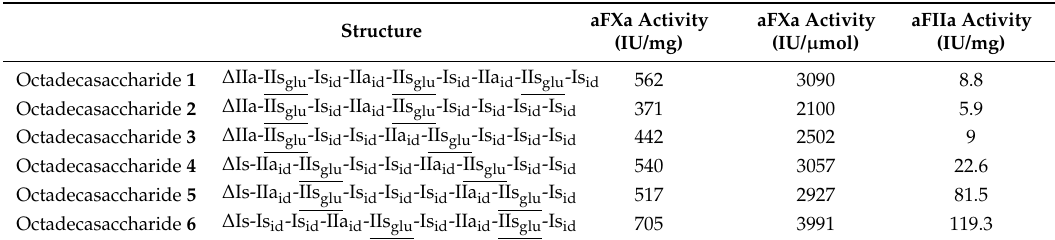
Table 5. aFXa and aFIIa activities of isolated